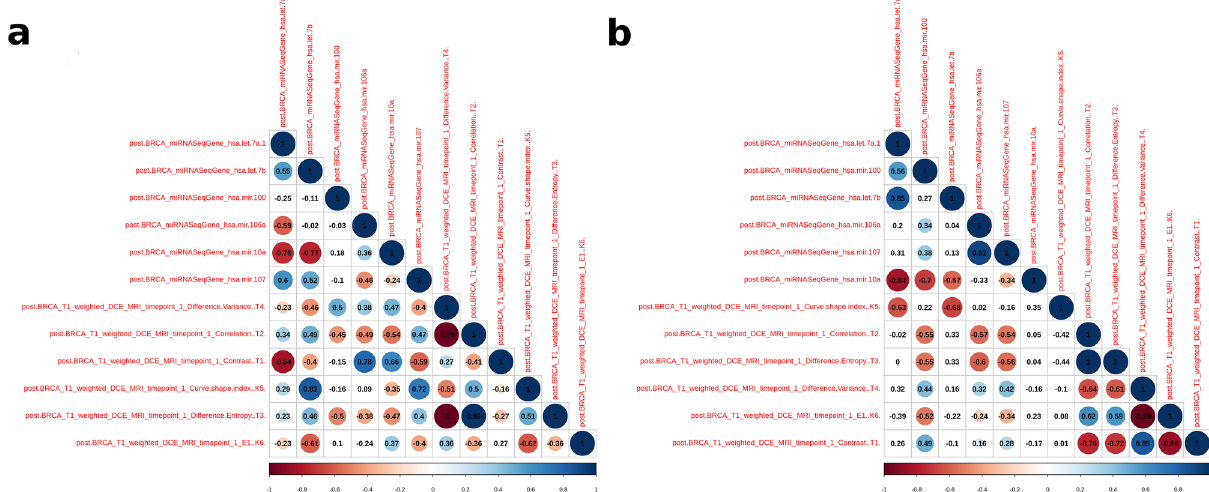
Figure 8. An example of correlation analysis for stage II. Correlation module is one of the downstream analysis modules. In this case, on the left-hand side ( a ), we extracted the correlation plot between radiomic and genomic features for stage IIA. In stage IIA, T1_weighted_DEC_MRI contrast shows a significant ( p value < 0.05) negative correlation (rho = -0.84) with miRNA_hsa.let.7a; whereas T1_weighted_DEC_MRI_curve_shape_index is significantly ( p value < 0.05) correlated (rho = + 0.83) with miRNA_hsa.let.7b. On the right-hand side ( b ), we extracted the correlation plot between radiomic and genomic features for stage IIB. In stage IIB, T1_weighted_ DEC_MRI_curve_shape_index shows significant ( p value < 0.05) positive correlations with both miRNA_hsa. let.7a and miRNA_hsa.let.7b. The figure is generated by using R software version 3.6.1 (https ://www.r-proje